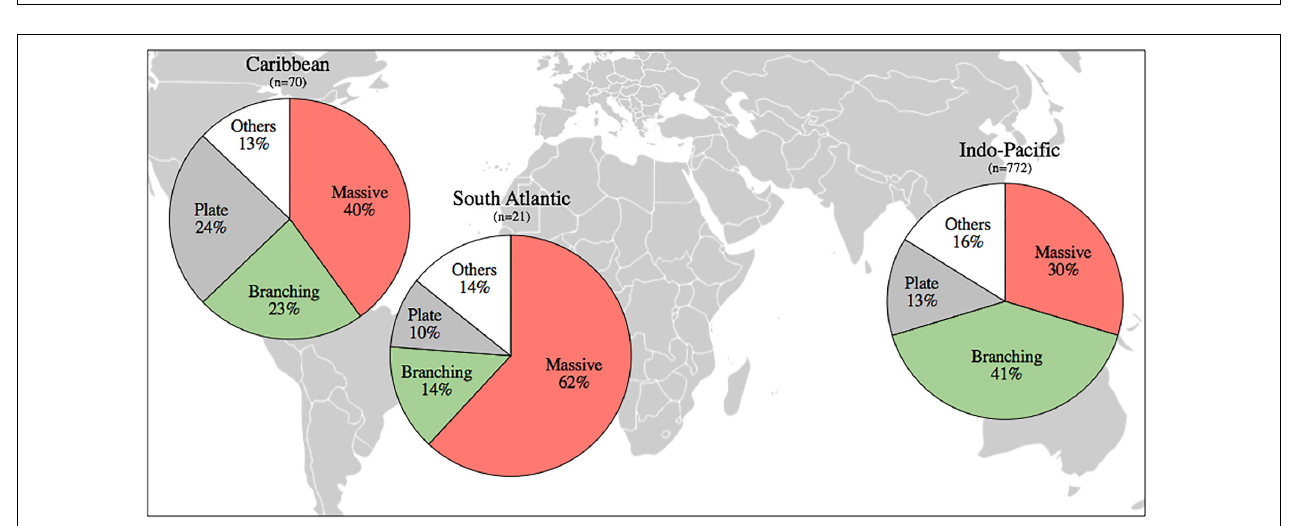
FIGURE 1 | Mean maximum depth reported for zooxanthellate scleractinian and hydrocoral species, proportion of species that are tolerant to turbid waters and NO 3 − (a proxy for nutrient enrichment) concentration in Indo-Pacific, Caribbean and South Atlantic coral reefs. Bars denote standard error.